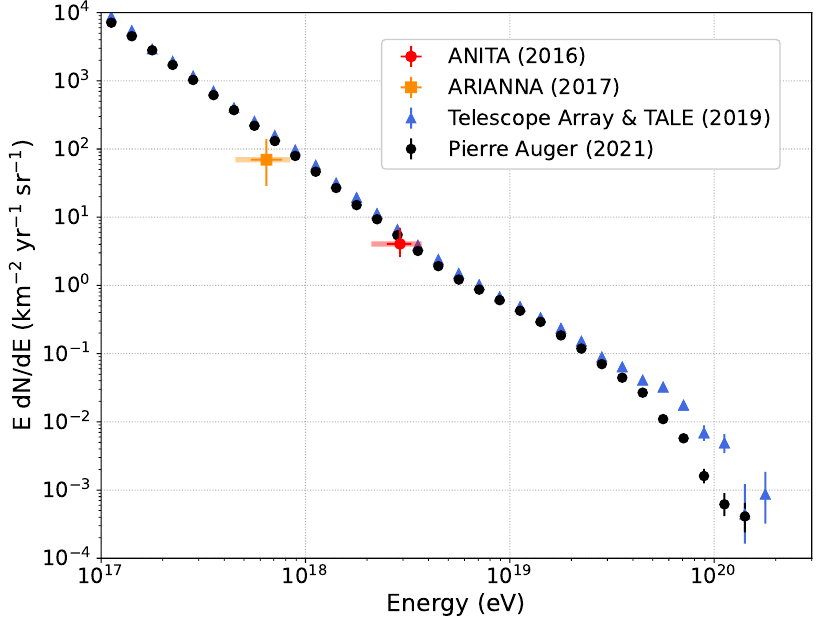
Figure 9. Flux of cosmic rays as a function of energy as measured in experiments using arrays of particle detectors and fluorescence telescopes (Telescope Array and TALE [135] and the Pierre Auger Observatory [6,136]), and using the radio technique (ANITA [61] and ARIANNA [134]). Error bars are statistical only. The shaded bands indicate the uncertainty on the energy scale of the experiments exploiting the radio